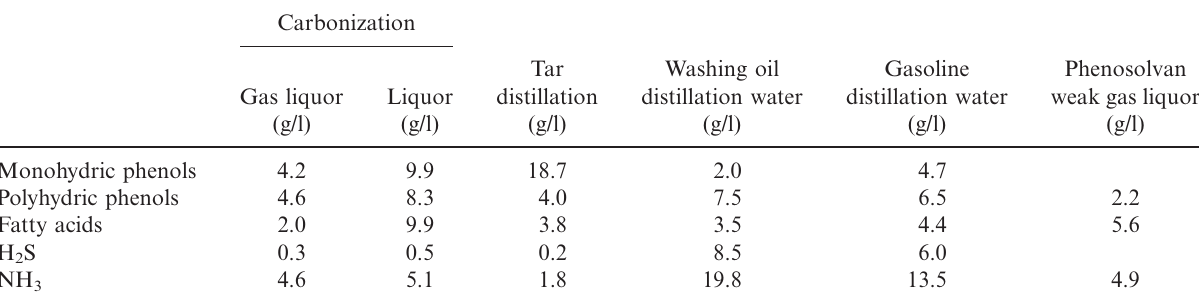
Table 2. Composition of phenolic waters from brown coal carbonization, gasification, and tar hydrogenation (Ringpfeil et al.